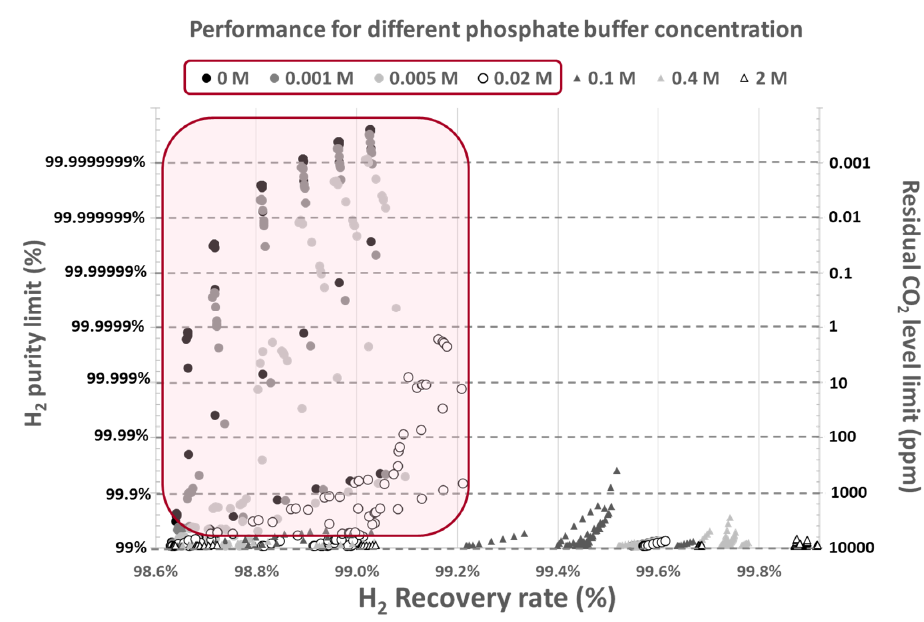
Figure 4. Residual CO 2 levels in the absorbent as a function of phosphate buffer concentration.